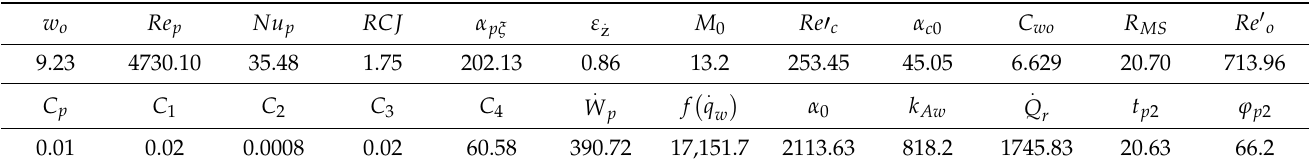
Table 4. Calculations for the first iteration of the evaporator.